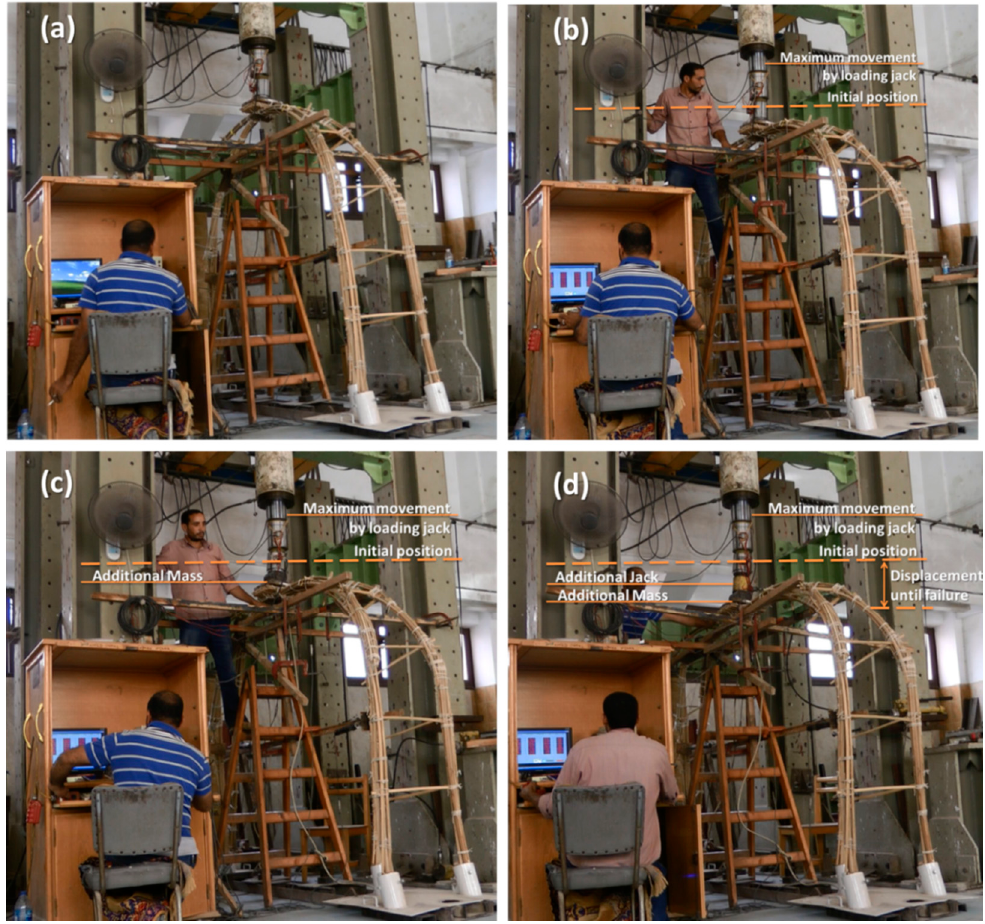
Figure 17. Experimentation of the second specimen. ( a ) Initial state before loading. ( b ) Reaching the maximum movement by loading jack for the 1st time: 250 mm. ( c ) Reaching the maximum movement by loading jack for the 2nd time. ( d ) Specimen at failure.